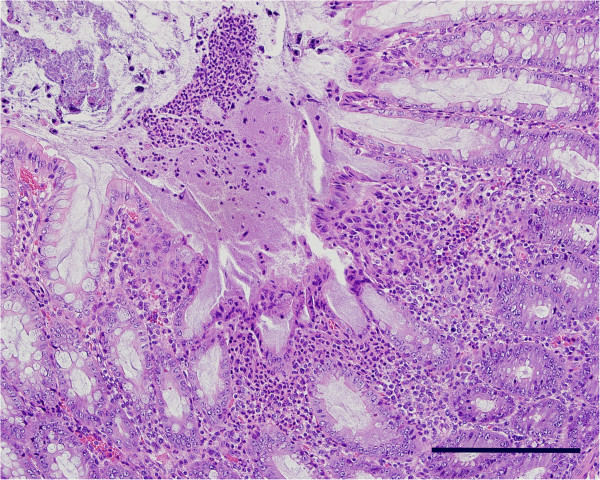
Brachyspira colitis. In a section of proximal colon (Pig #671) there is a focal area of epithelial necrosis surrounded in the lamina propria by a mixed inflammatory infiltrate composed primarily of degenerate neutrophils, and covered by a thick mat of mucous containing degenerate neutrophils, necrotic epithelial cells, and bacterial colonies. Hematoxylin and Eosin. Bar = 200 μm.